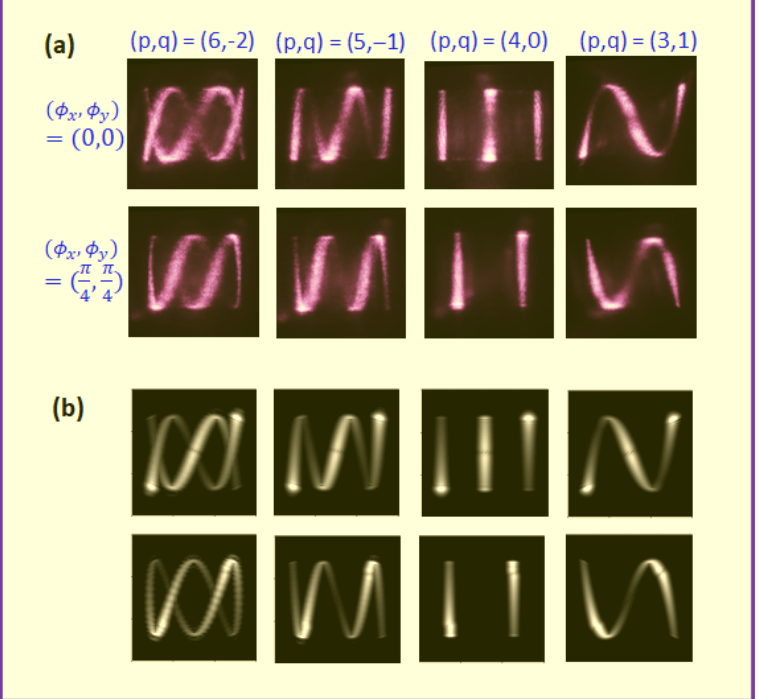
Figure 17. ( a ) Experimental results for the far-field patterns of Lissajous geometric modes generated by using an output coupler with T oc = 15%. ( b ) Numerical patterns obtained from Equation (57) with the parameters used in Figure 16 ( b ).